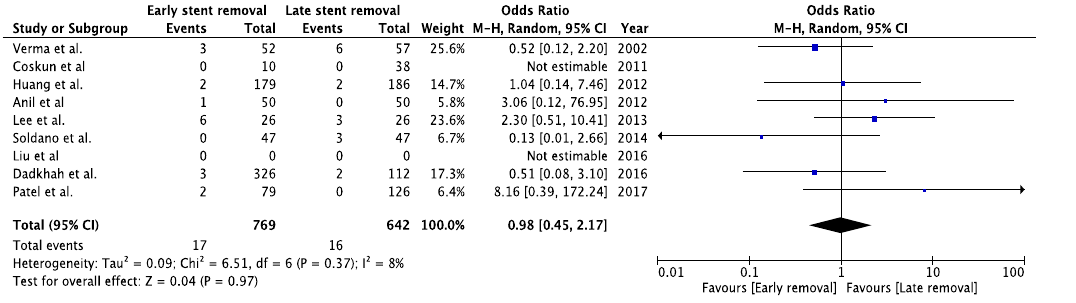
Figure 4. Forest plot urinary leakage for early (<3 weeks) versus late (>3 weeks) stent removal.